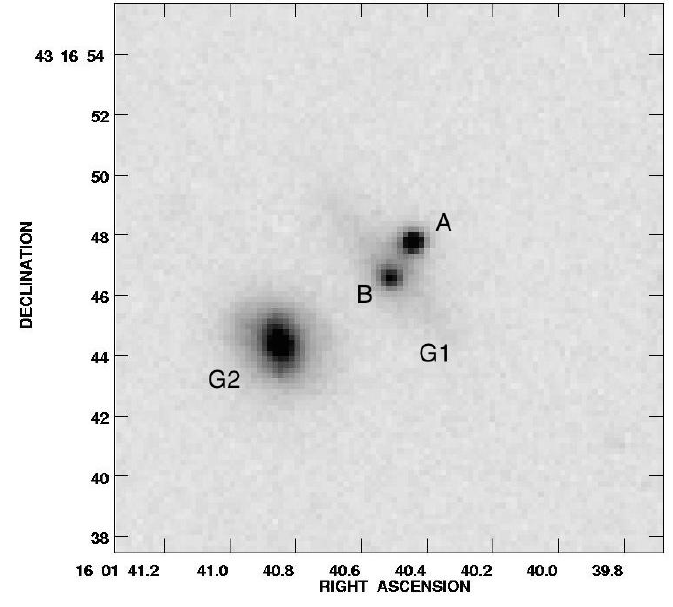
Figure 1. I-Band Nordic Optical Telescope image of B1600+434 showing the two lensed images A and B, the main lensing (edge-on spiral) galaxy (G1) and a secondary lensing galaxy G2 [6]. Both galaxies are at z =